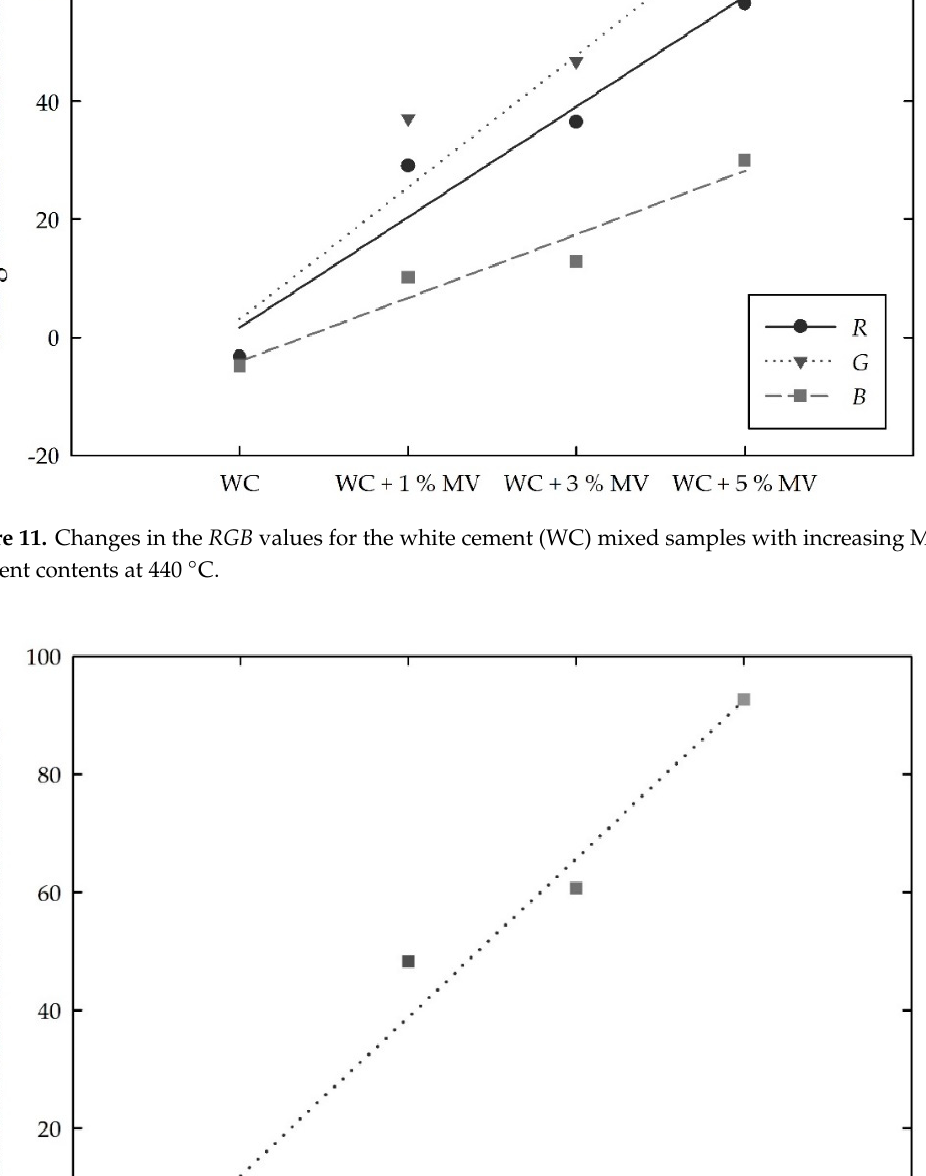
Figure 12. Total distance in the RGB intensities for the white cement (WC) mixed samples with increasing MV pigment content at 440 ° C.